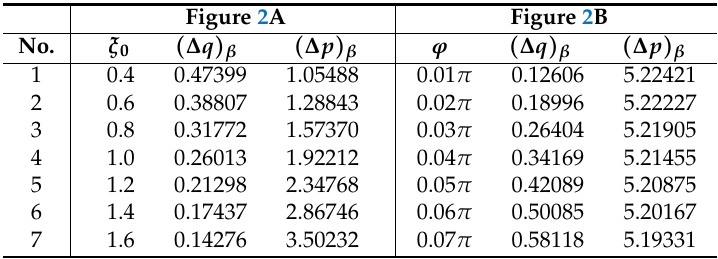
Figure 2. Temporal evolution of the geometric phase for several values of ξ 0 ( A ) and ϕ ( B ). ( C ) is 3D plot of the geometric phase versus ϕ and t . ( D ) is an enlarged view of a part of ( C ), which is within 6.1 ≤ ϕ ≤ 6.5. We used ( α 0 , ϕ ) = (1, 0) for ( A ), and ( α 0 , ξ 0 ) = (1.5, 2) for ( B – D ). All other values are common and given by λ = 0, ω = 1, θ = 0, and γ 0 = 0. From this figure, we can confirm the effects of squeezing parameters [ ξ 0 ( A ) and ϕ ( B – D )] on the geometric-phase oscillation. Table 1. Fluctuations of the canonical variables q and p for each curve in panels A and B in Figure 2. These are evaluated from Equation (6) with the option of (cid:101) = 1 and ¯ h = 1. Figure 2A Figure